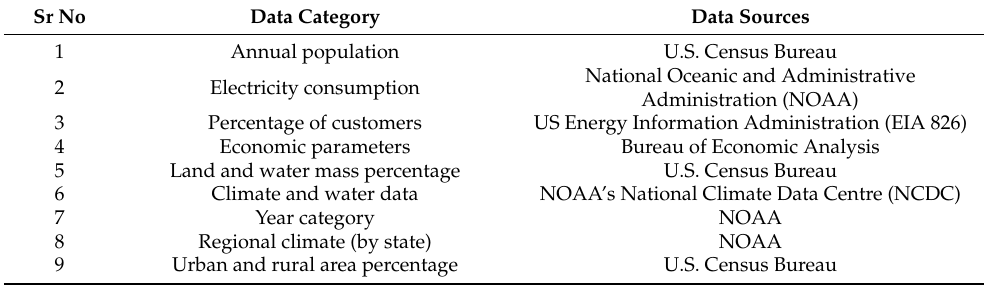
Table 1. Historical data categories and their respective sources [28].